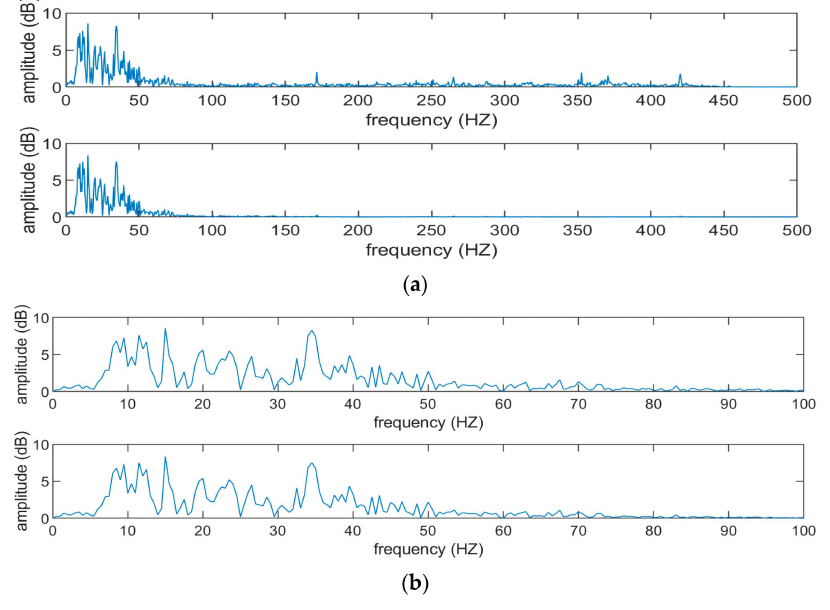
Figure 12. Actual micro-seismic data before and after denoising by CEEMDAN-FE-TFPF.